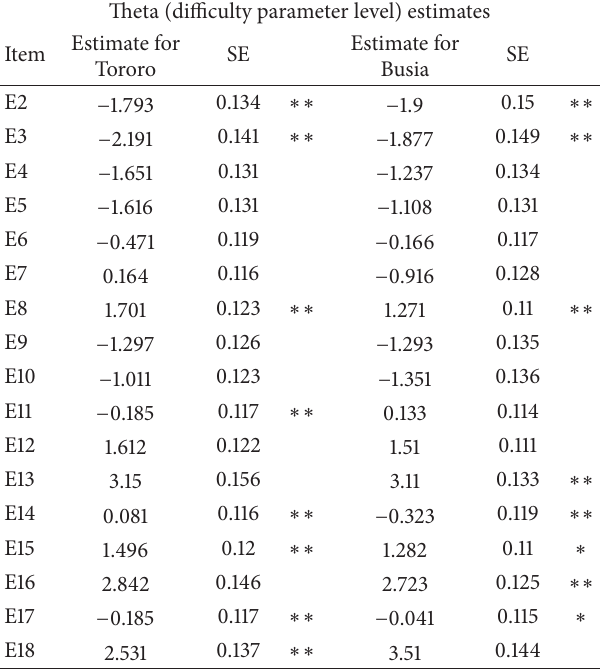
Table 5: Descriptive statistics for household food security for Tororo and Busia districts. Household score on food security